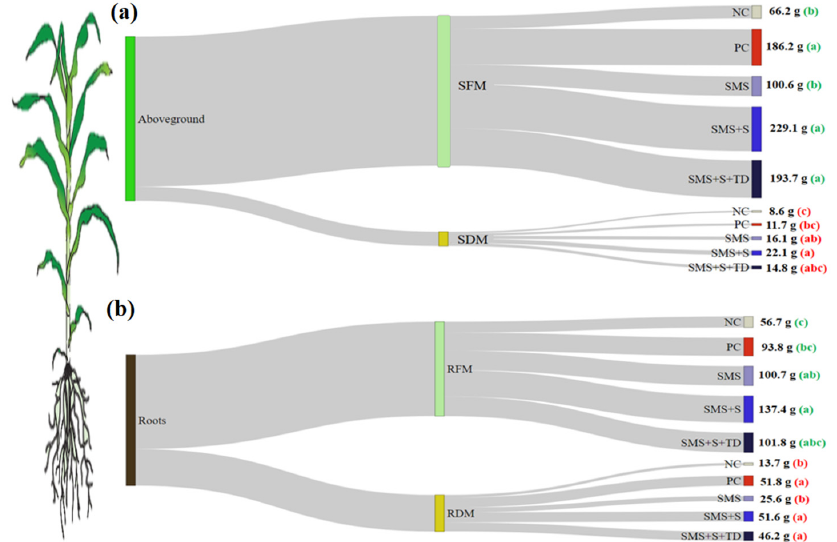
Figure 1. Aboveground and root mass of maize under different SMS managements at 70 DAS. SFM: shoot fresh matter and SDM: shoot dry matter (a), RFM: root fresh matter and RDM: root dry matter (b). Means followed by different lowercase letters for the same color differ according to Tukey’s test ( p > 0.05).